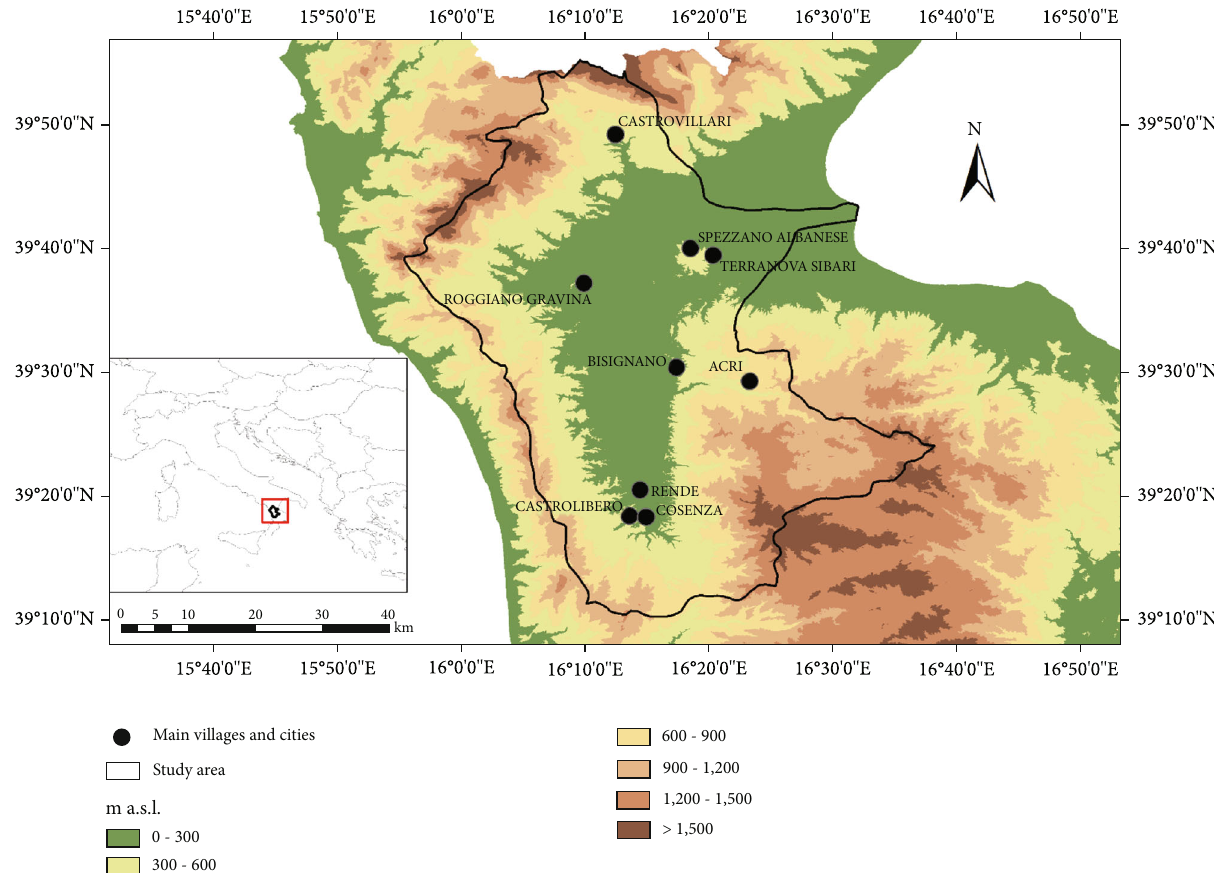
Figure 1: Crati river